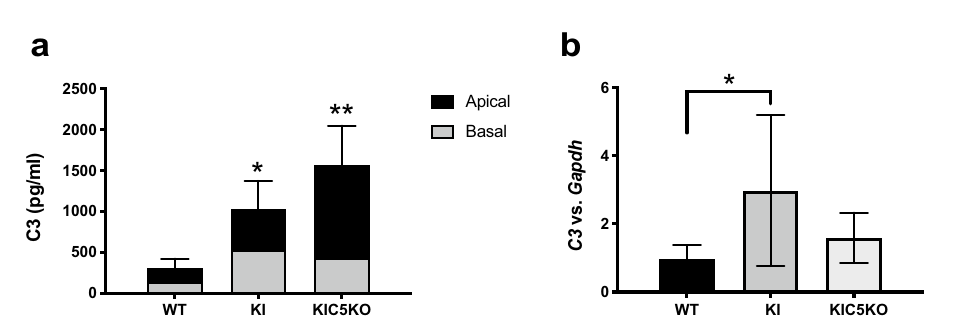
Figure 5. Levels of C3 measured by ELISA in the apical and basal conditioned media of RPE cultures showed increased levels of C3 in Efemp1 R345W/R345W :C5 + / + and Efemp1 R345W/R345W :C5 -/- cultures compared to controls. Data from apical and basal side were combined for statistics. This represents the reality with better accuracy, since the basal conditioned media needs to be concentrated three times more, which results in more protein lost in the Amicon filter. Also C3 proteins secreted to the basal side can remain trapped inside the pores of the transwells 18 . Data represented as average ± SD (2-way ANOVA, * p < 0.05, ** p <